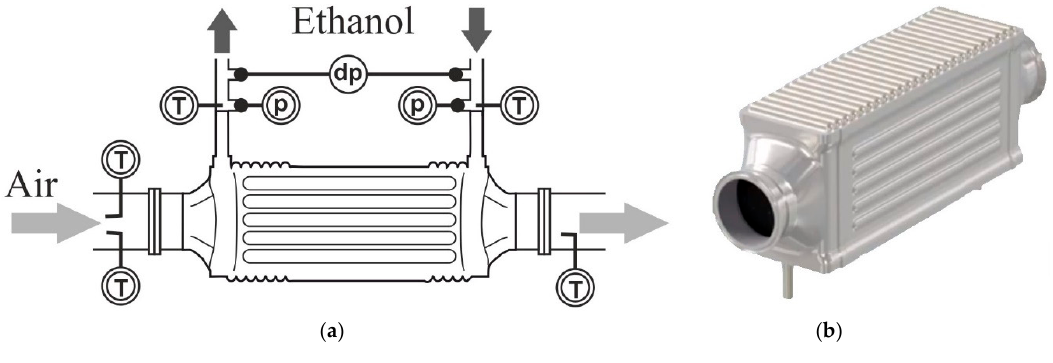
Figure 2. Experimental boiler: scheme ( a ) and photograph ( b ).